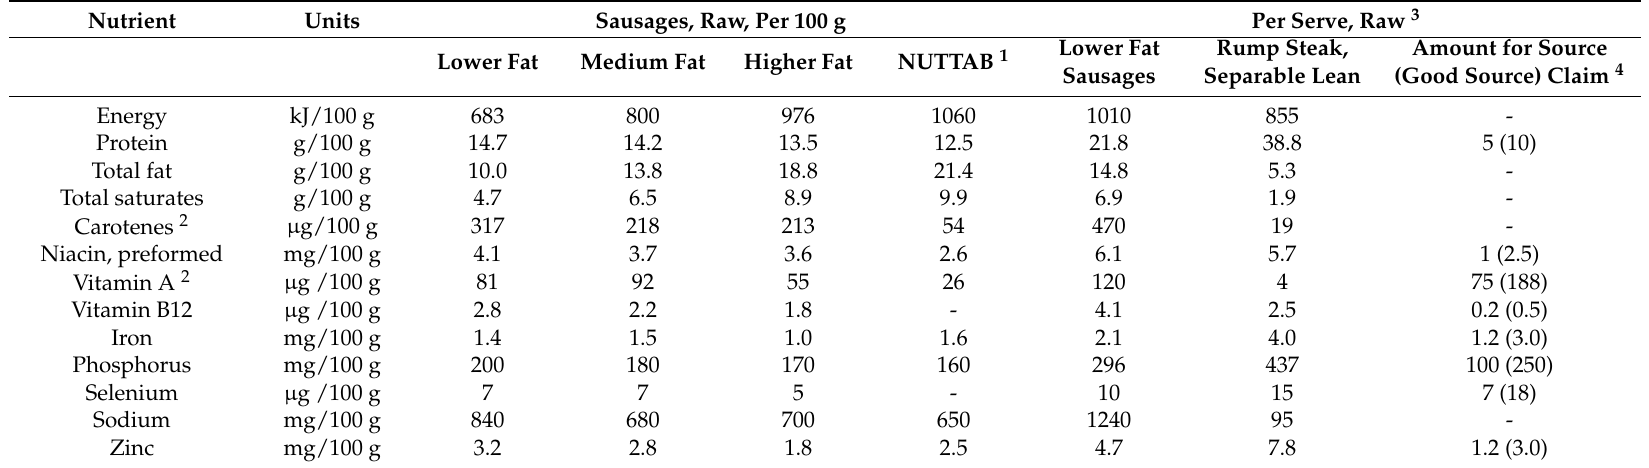
Lower Fat Rump Steak, Amount for Source Sausages Separable Lean (Good Source) Claim 4